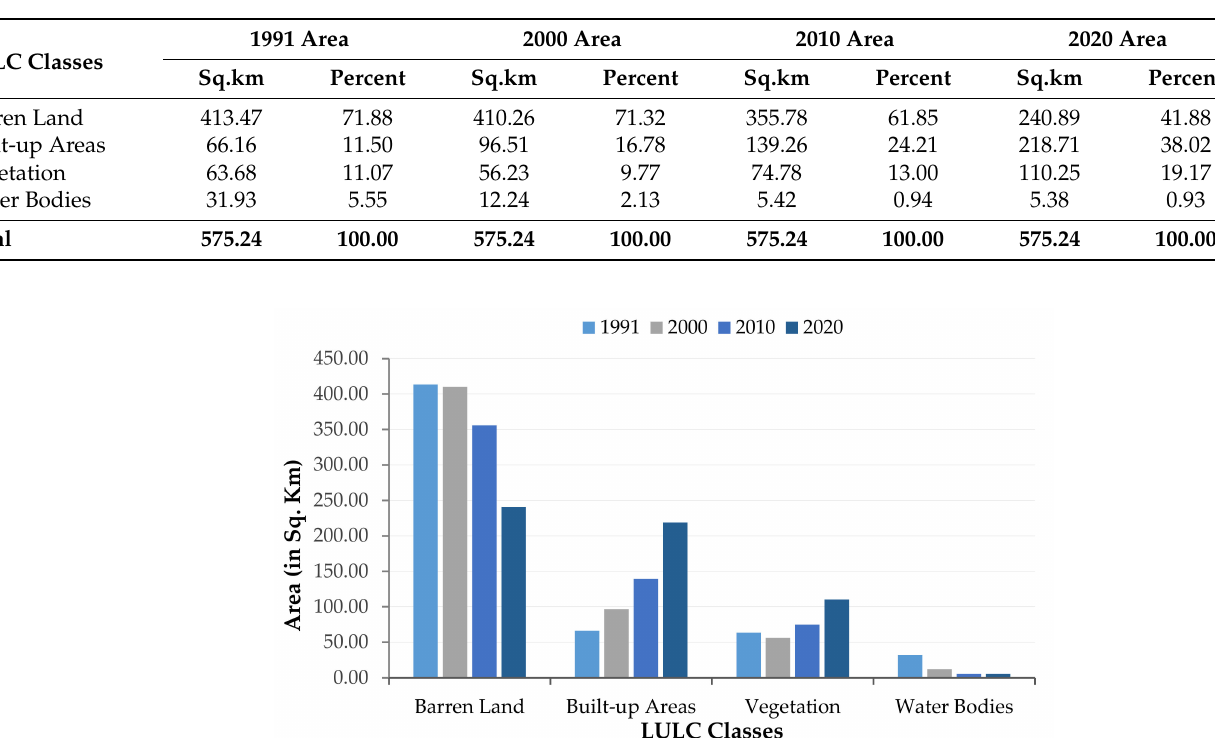
Table 5. Statistical Data of the LULC classes.